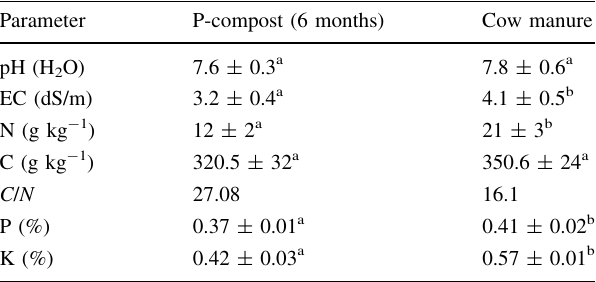
Table 1 Characteristics of palm compost and cow manure